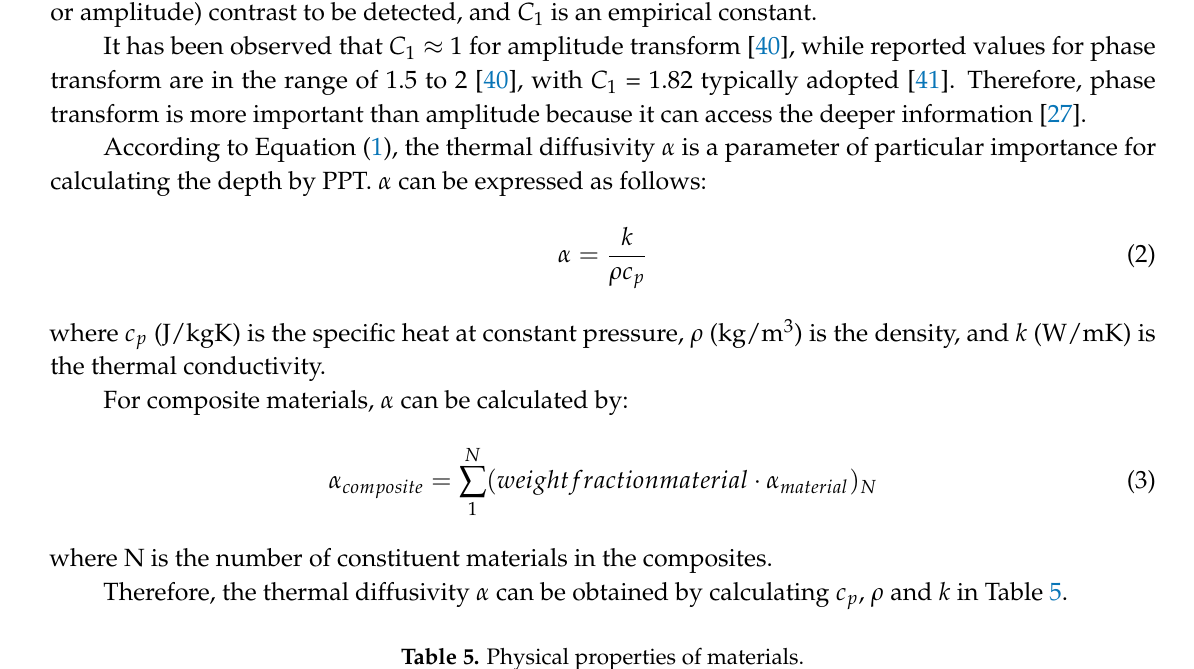
Table 5. Physical properties of